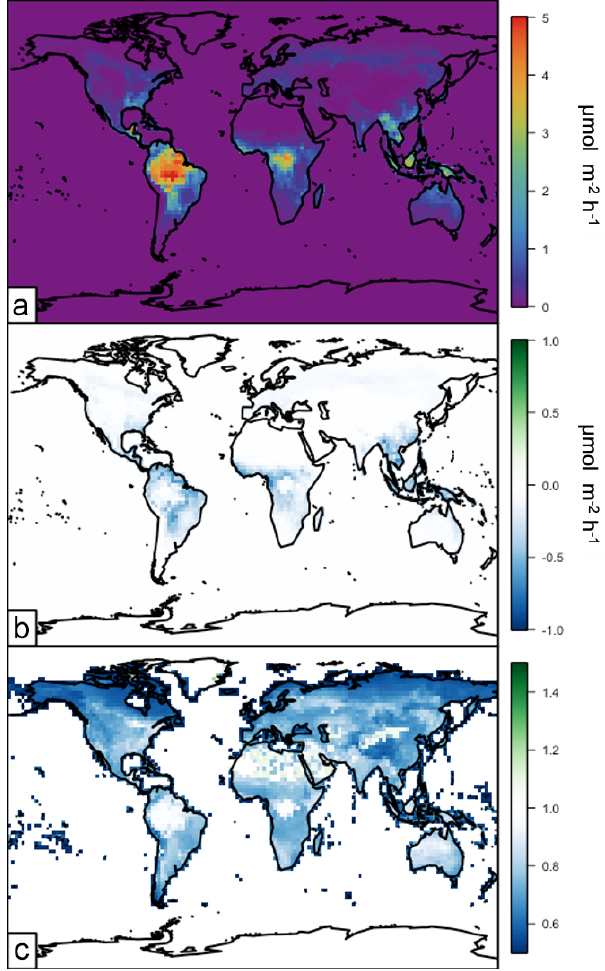
Figure 11. Annual average (2012) monoterpene emissions simu- lated in GEOS-Chem driven by the surrogate model canopy physics. Panel (a) shows the annual average emissions. Panel (b) shows the difference between the surrogate model and the base version of sim- ulated emissions. Panel (c) shows the relative difference between the surrogate model and the base version of simulated emissions (surrogate–base